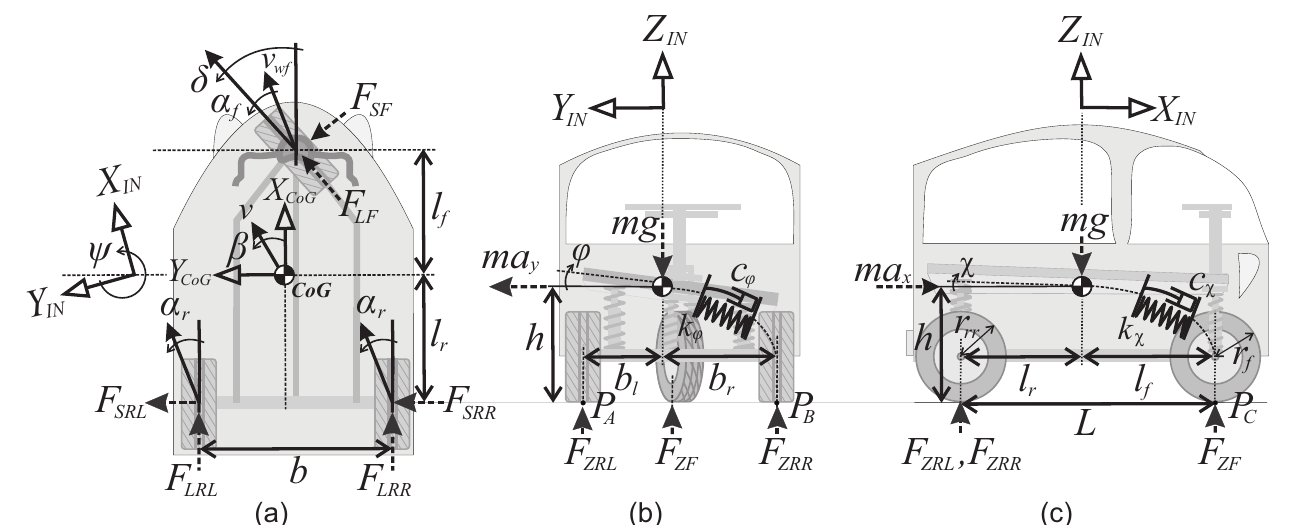
Figure 1. Idealizations and free-force diagrams for the TWV: ( a ) upper view, ( b ) back view, and ( c ) right view. Mechanical and regenerative braking are considered a single force for each